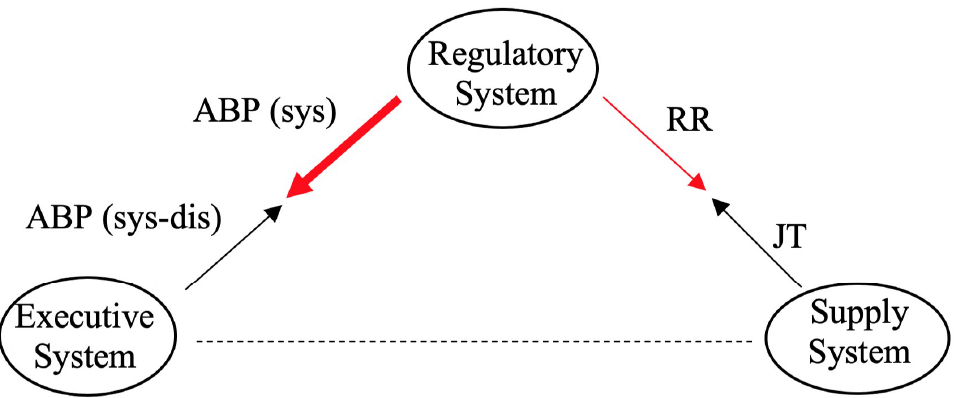
Figure 2. A simplified schematic diagram illustrating the interconnectivity of the Executive System, the Supply System, and the Regulatory